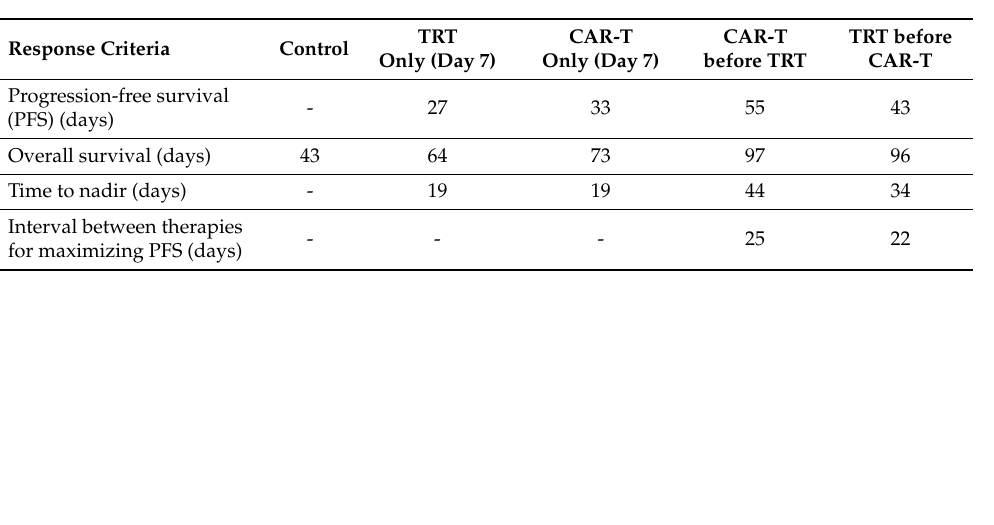
Figure 2. CAR-T cell data and model parameters. ( A ) Estimation of CAR-T cell persistence ( θ ). Three mice were sacrificed and ( B ) the percentage of CAR-T cells to tumor cells on day 28 post- tumor cell engraftment was used to estimate the CAR-T cell death rate θ (1/time). ( C ) Tumor burden as measured with BLI in radiance (rad) for the untreated control mice (N = 7) following the administration of 1 million MM1S multiple myeloma cells at time t = 0 to estimate the net tumor growth rate ( ρ ). ( D ) CAR-T cell killing ( k 1 ) and proliferation/exhaustion ( k 2 ) parameters are estimated by fitting the mathematical model to the BLI data (*) from mice treated with CAR-T cells on day 7 (N = 3). Table 2. Simulated measures of tumor response to individual and combination therapies. The first therapy is given seven days post tumor initiation. For the combination therapy, the second therapy is given seven days following the first